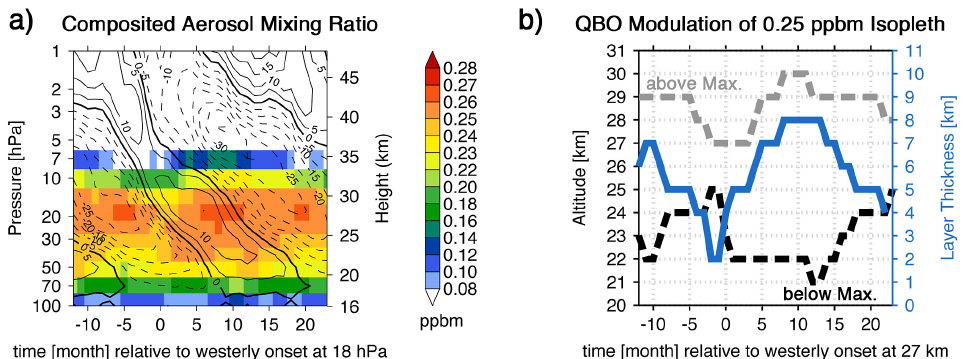
Figure 5. (a) Composite of the simulated aerosol mixing ratio in the QBO-nudged model relative to the onset of residual westerlies at 18hPa corresponding to the time series Fig. 3b. Data are averaged between 5 ◦ N and 5 ◦ S for the years 1996–2006. (b) Composite of the height variation of the 0.25ppbm isopleth above (grey) and below (black) the mixing ratio maximum from panel (a) . The blue line is the corresponding vertical extend between those two isopleths as an approximate measure of the QBO modulation of the Junge layer thickness with time. Geometric altitudes in (b) have been inferred from the model’s sigma-hybrid levels, whereas in (a) the approximate altitude of the pressure levels, based on the ICAO standard atmosphere, are